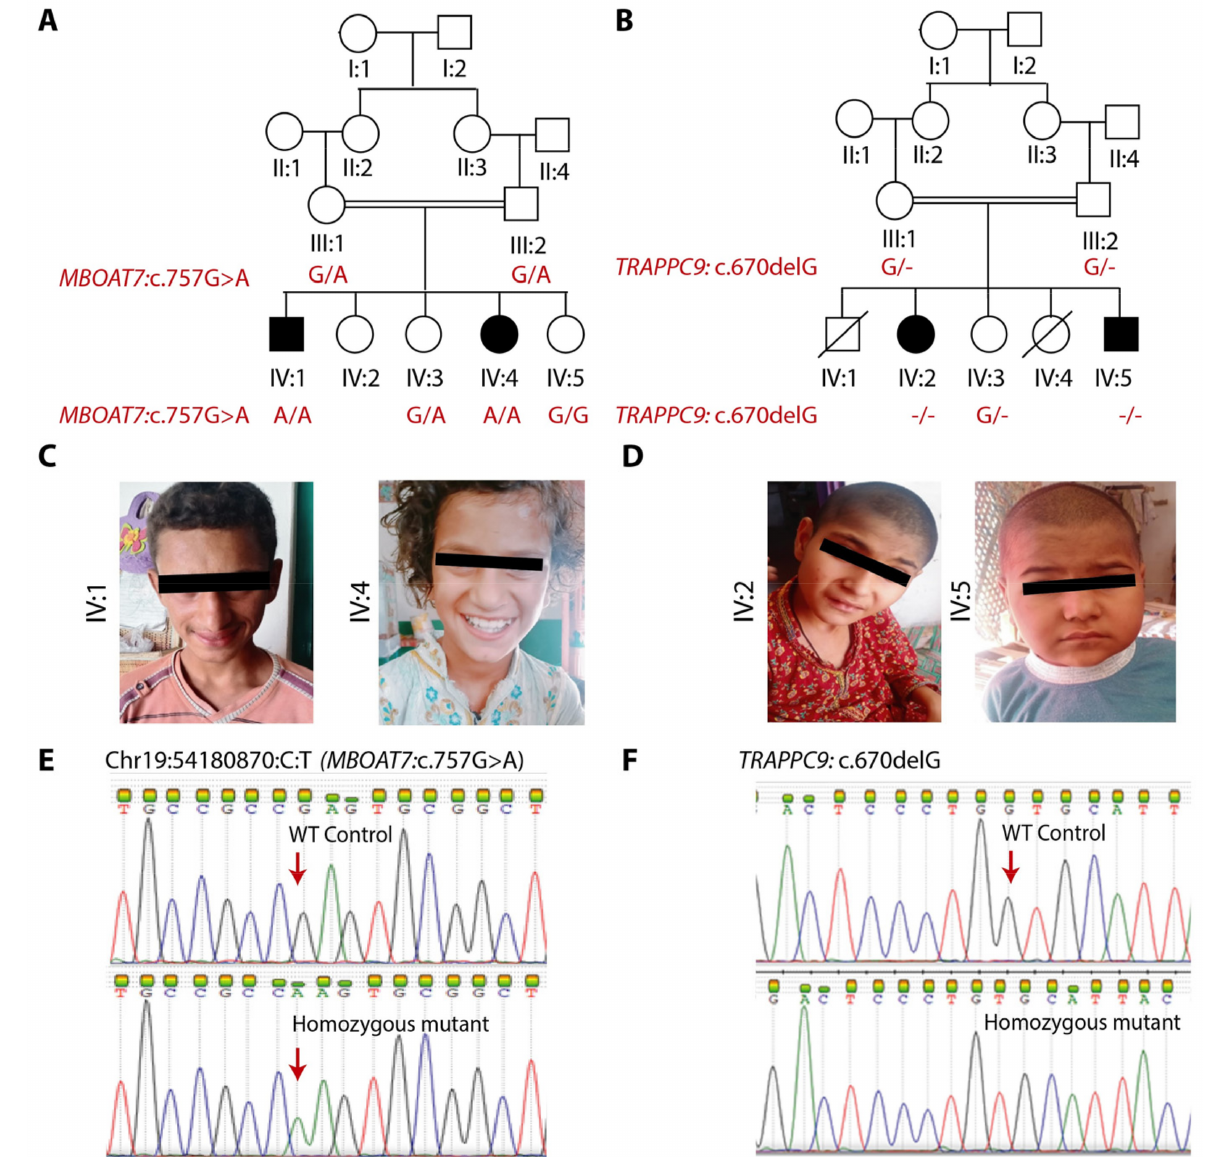
Figure 1. Clinical and genetic findings of families A and B ( A ) Pedigree of family A along with genotypes of candidate variant in MBOAT7 showing its co-segregation. ( B ) Pedigree of family B along with genotypes of candidate variant in TRAPPC9 ( C ) Frontal poses of patients of family A showing normal facial features. ( D ) Frontal poses of affected individuals of family B without any signs of facial deformities. ( E ) Sanger traces of the genomic region of MBOAT7 showing identified variant in the affected member compared to the control. Arrow shows the position of the mutant nucleotide. ( F ) Sanger traces for mutation spanning region in of TRAPPC9 showing wild-type sequence in a control individual in the upper panel, whereas it shows homozygous deletion c.670delG in the lower panel, as observed in both